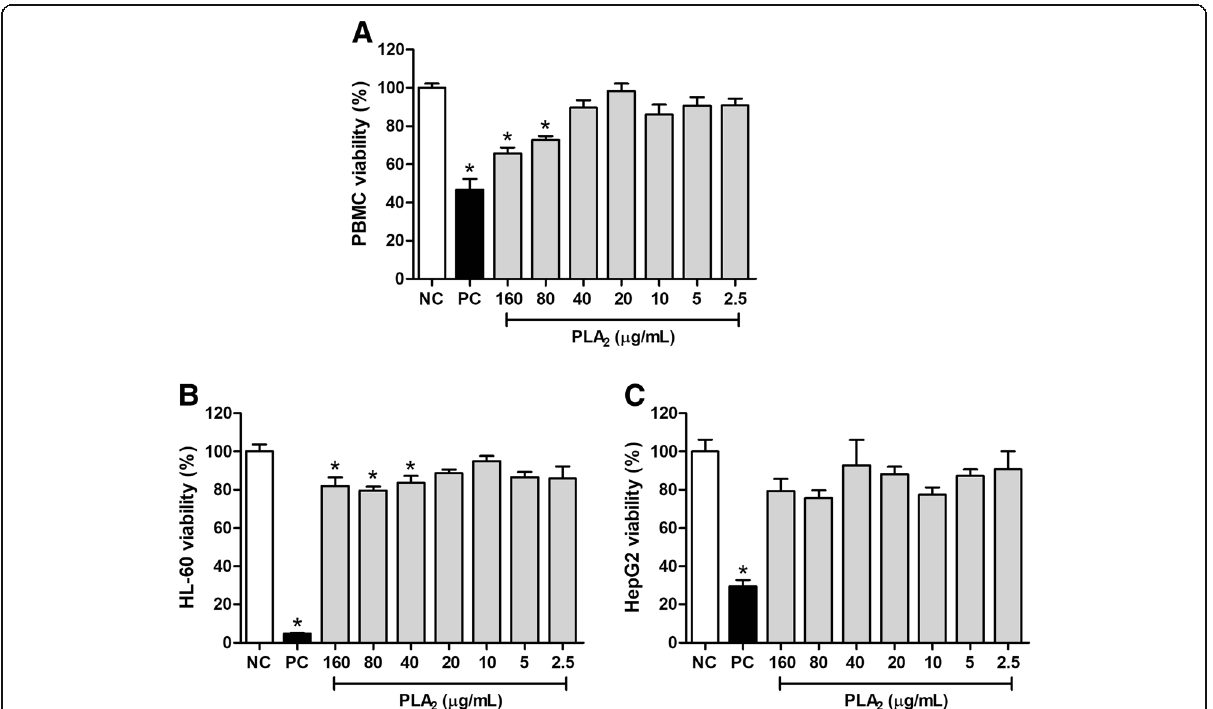
Fig. 10 Evaluation of the cytotoxic effects induced by BJ-PLA 2 -I on normal and tumor cells. Cell viability of PBMC ( a ), HL-60 ( b ) and HepG2 ( c ) was assessed by the MTT method after a 24 h stimulation period with BJ-PLA 2 -I at different concentrations (2.5 – 160 μ g/mL). Cells treated only with sterile PBS were used as negative controls (NC). The positive controls (PC) received cisplatin (Incel, Darrow®) at the final concentration of 250 μ g/mL. Results were expressed as mean percentages (in relation to the negative control, considered as 100%)±SD ( n =3) of two independent experiments. * p <0.05 compared to the negative control